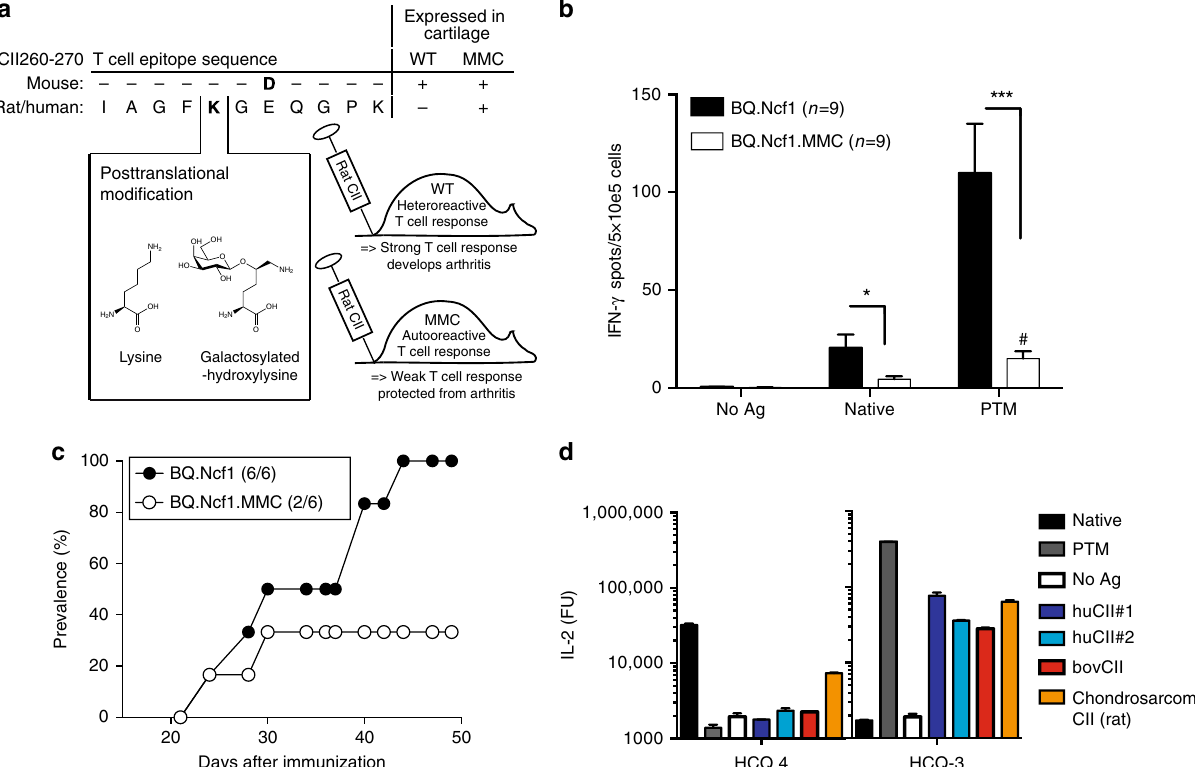
Fig. 1 Summary of the autologous CIA model. a The MMC mouse expresses the immunodominant T cell epitope of heterologous (rat/human) CII as a self- antigen in the cartilage. A D266E amino acid substitution is the only difference between mouse and heterologous CII. A lysine at position 264 can become post-translationally modi fi ed by hydroxylation (not shown) and subsequent glycosylation with a monosaccharide. These modi fi cations are recognized by distinct T cell clones (shown in d ). MMC mice are immunized with heterologous CII (in this study rat CII) in order to induce an autoreactive T cell response. b The Ncf1 mutation was inserted onto the BQ background in order to render arthritis susceptibility in MMC mice. IFN- γ ELISPOT of lymph node cells isolated 10 days after immunization with rat CII and following re-stimulation with the non-modi fi ed (native) or glycosylated (PTM) CII peptide are shown. Bars indicate the mean number of spots ± SEM. # Statistical signi fi cance ( p = 0.0195) between native and PTM responses in BQ.Ncf1.MMC mice, using a Wilcoxon's test. c Arthritis susceptibility of MMC mice in the BQ.Ncf1 background is reduced but not completely abrogated, when compared to non-MMC littermates. Number in brackets indicates cumulative number of animals that developed arthritis over total number of animals. d IL-2 production of T cell hybridoma clones speci fi c to either the non-modi fi ed (HCQ.4) or PTM (HCQ.3) variants of the CII 260 – 270 epitope after stimulation with the different peptides as well as whole CII protein obtained from different species (hu, human (two independent preparations/samples); bov, bovine (calf) CII from joint cartilage. The chondrosarcoma is a rat tumor line that was used as a positive control as it produces CII that is very heterogeneous in terms of PTMs 19 ). Mann – Whitney U test was used in ELISPOT assays. * p < 0.05; *** p <